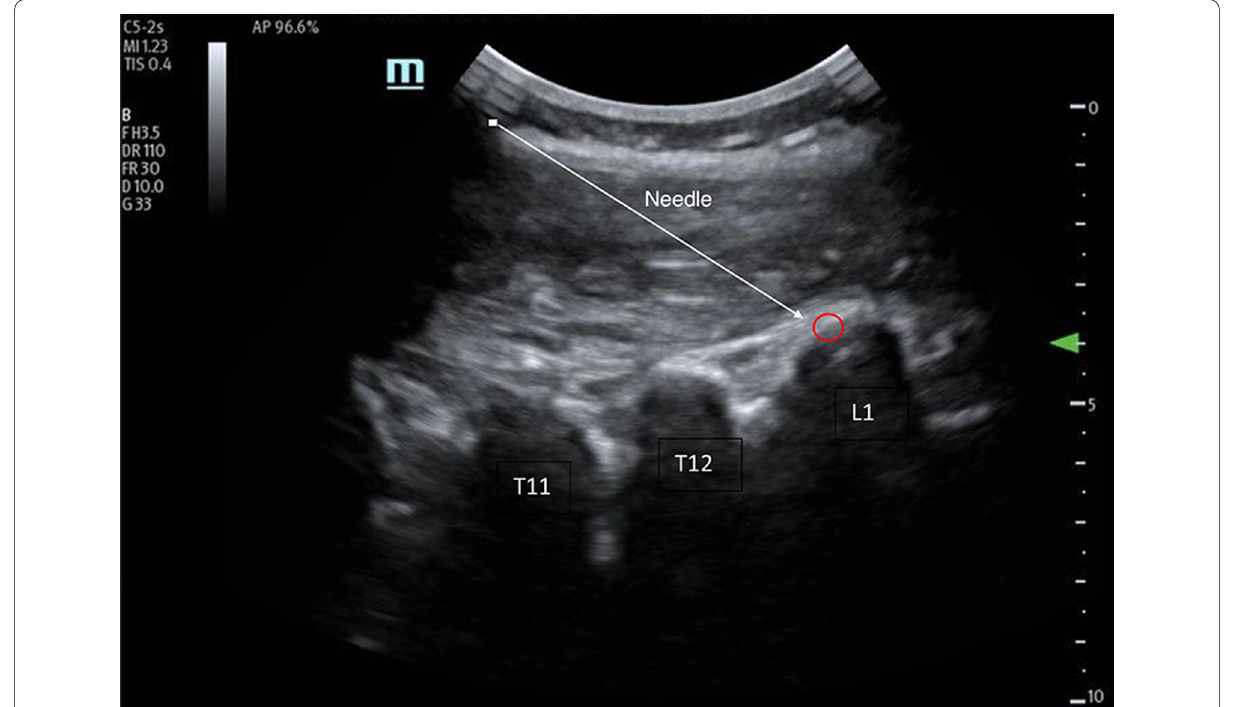
Fig. 1 Longitudinal needle guidance to the L1 transverse